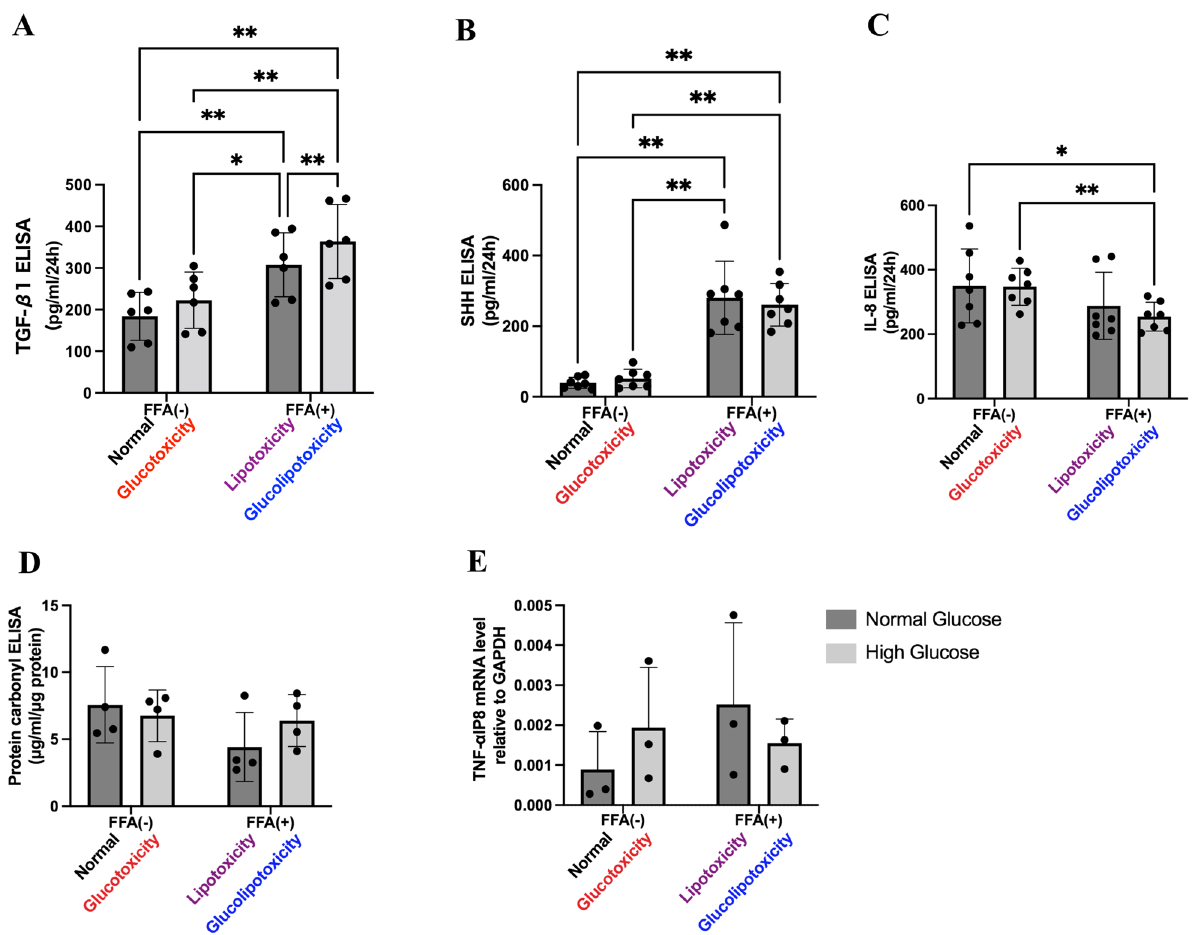
Figure 6. Functional analyses. ( A ) Evaluation of TGF-β1 levels in culture supernatant by ELISA. TGF- β1 levels were significantly higher in lipotoxicity and glucolipotoxicity groups compared to control and glucotoxicity groups. n = 6, 3 independent experiments, ** p < 0.01, * p < 0.05. ( B ) Evaluation of SHH levels in culture supernatants by ELISA. SHH levels were significantly higher in lipotoxicity and glucolipotoxicity groups compared to control and glucotoxicity groups. n = 7, 3 independent experiments, ** p < 0.01, * p < 0.05. SHH: Sonic hedgehog. ( C ) Evaluation of IL-8 levels in culture supernatant by ELISA. IL-8 levels were significantly higher in the lipotoxicity and glucolipotoxicity groups compared to control and glucotoxicity groups. n = 6, 3 independent experiments, ** p < 0.01 * p < 0.05. ( D ) Evaluation of protein carbonyl levels in PHH/HSC sheet lysates by ELISA. Protein carbonyl levels were not significantly different between groups. n = 4. ( E ) Evaluation of TNFα-IP8 mRNA expression in PHH/HSC sheets by RT-qPCR. GAPDH was used as normalizer. No significant difference was observed between groups. n = 3, 3 independent